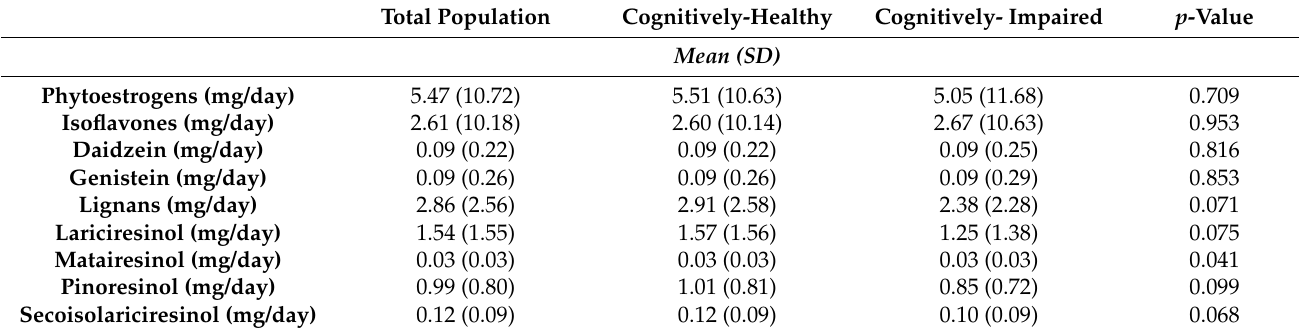
Table 2. Average total phytoestrogen and individual compound intake in the sample, total and by cognitive